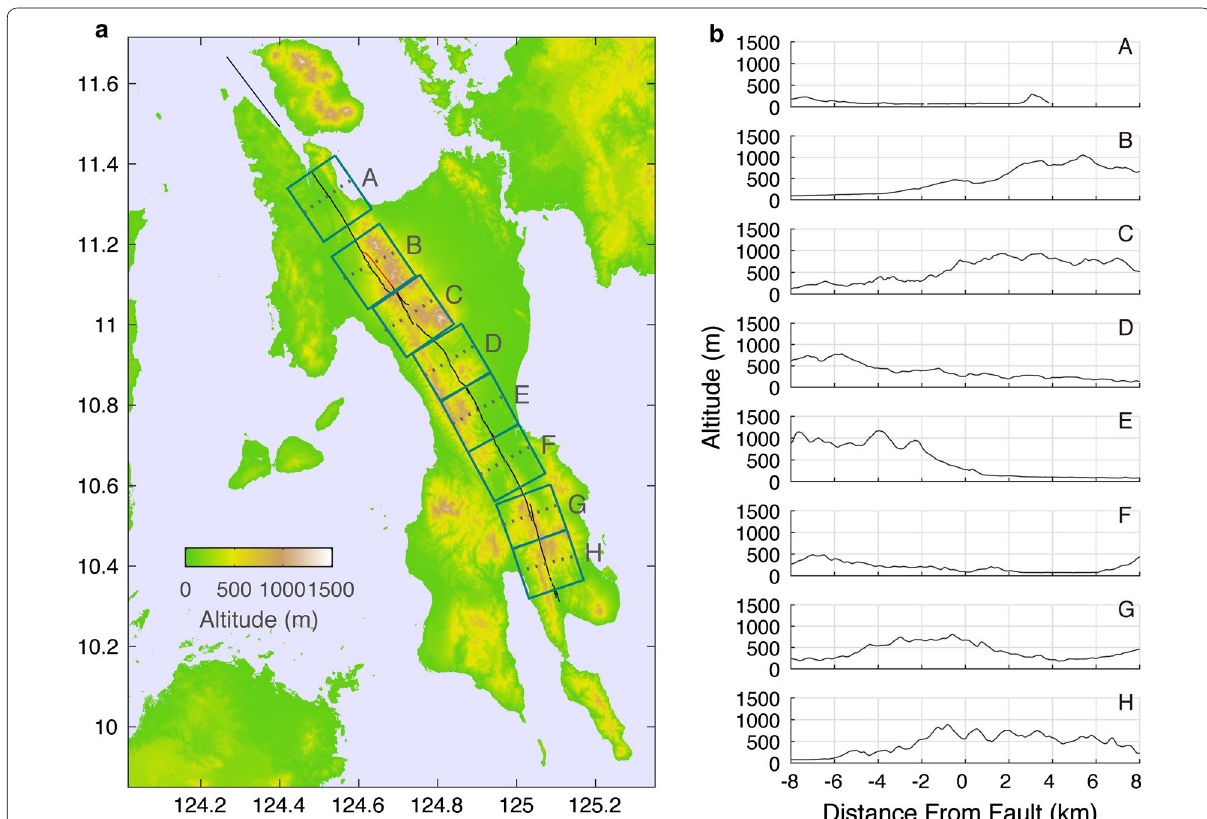
Fig. 3 a Topography map of the Leyte Island, shown with the Philippine fault traces mapped by Tsutsumi and Perez (2013) (black) and a branched trace mapped by Prioul et al. (2000) (red). b Elevation profiles across the fault (Tsutsumi and Perez 2013) along selected lines shown in a . The location of each line corresponds to the center of the boxes shown in later figures